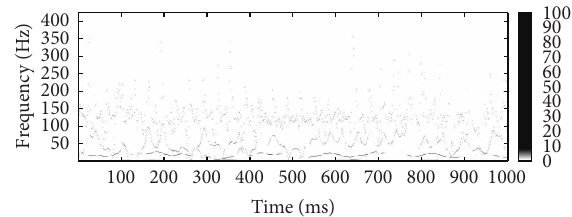
Figure 21: Intensity matrix of inner ring fault signal.